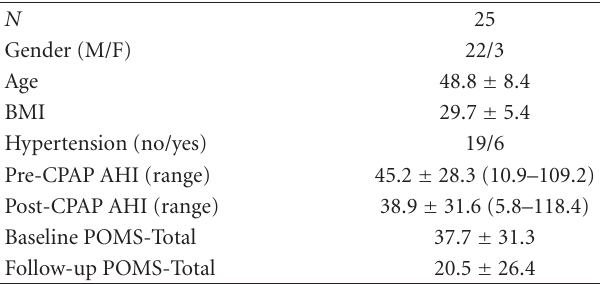
Table 1: Participant characteristics (Mean ±